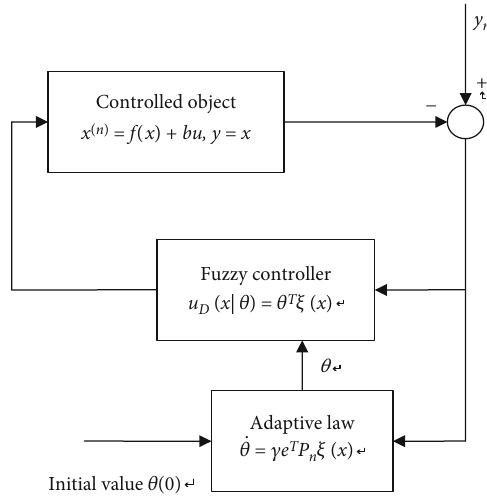
Figure 4: Direct type adaptive fuzzy